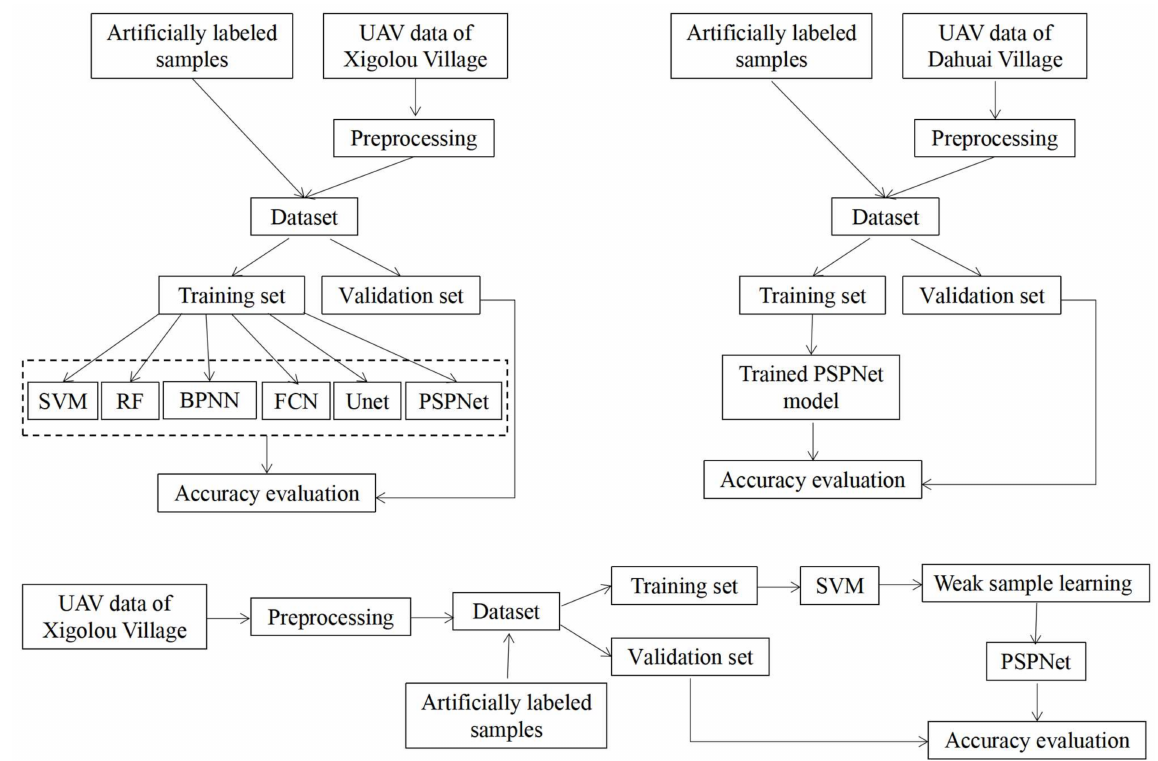
Figure 3. The general roadmap and the experimental components of this